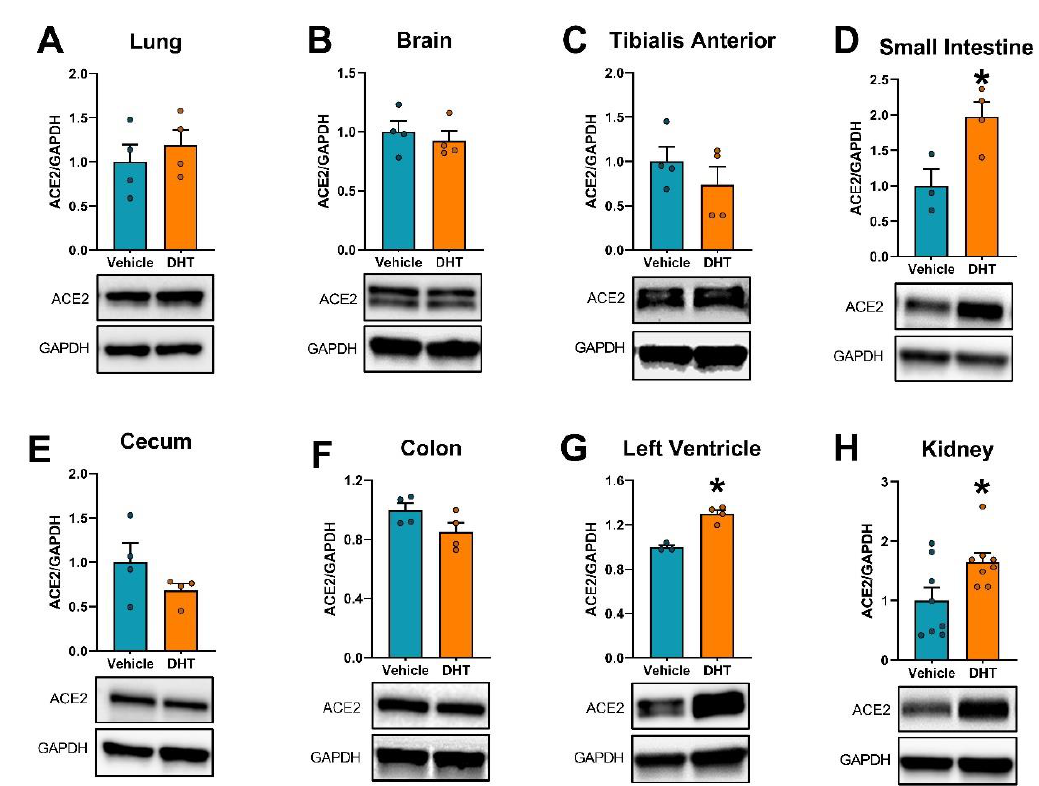
Figure 4. ACE2 protein expression regulation by DHT in different tissues. ACE2 protein expression was quantified by Western blot. ACE2 protein expression in the lung ( A ), brain ( B ), tibialis anterior ( C ), small intestine ( D ), cecum ( E ), colon ( F ), left ventricle ( G ), and kidney ( H ) of control and DHT-treated mice. Protein expression was normalized to GAPDH and expressed relative to control mice. Data analyzed by t-test. n = 3 – 8/group. *: p < 0.05.